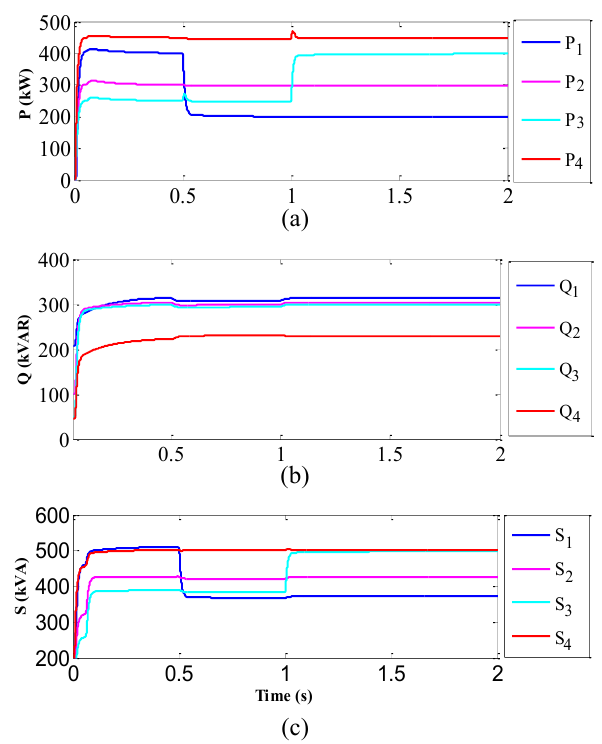
Fig. 6. Results with ERPS algorithm: (a) active power fed by DGs, (b) reactive power shared by the inverters, (c) apparent power of each inverter